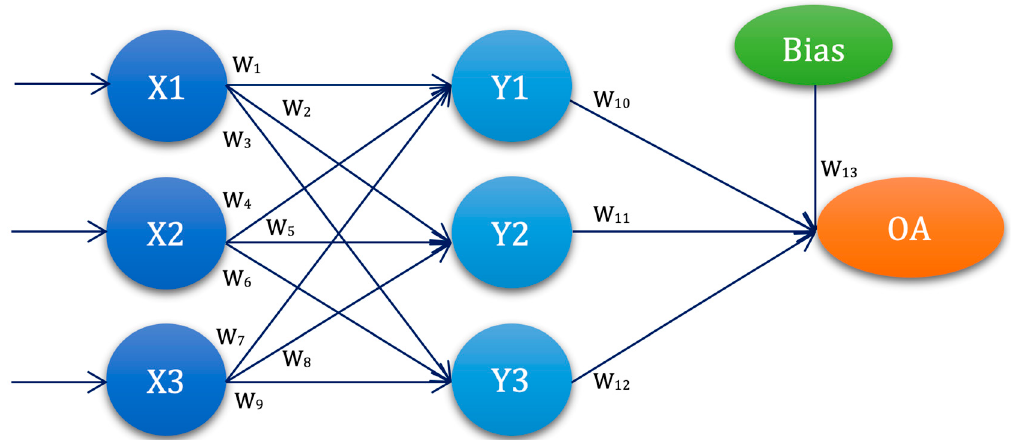
Figure 1. ANN-L27 architecture—graphical representation. The graphical representation of the ANN-L27 architecture in Figure 1 is constructed based on the L27 orthogonal plan, with three input values, one hidden layer with three nodes, and one output. ANN-L27 has a three-level architecture and thirteen weighting coefficients. Table 1. ANN-L27 orthogonal vector plan.